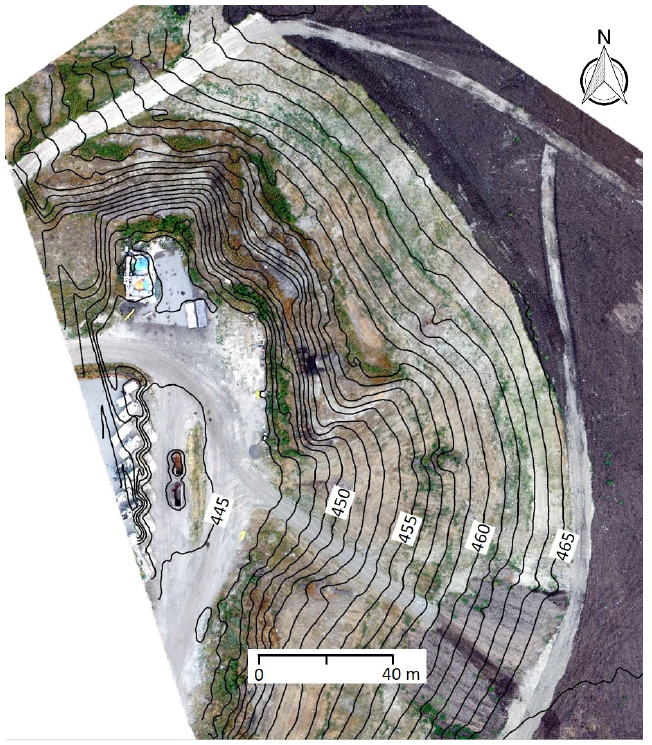
Figure 4. Contour map (1 m contour intervals) of the monitored location within the